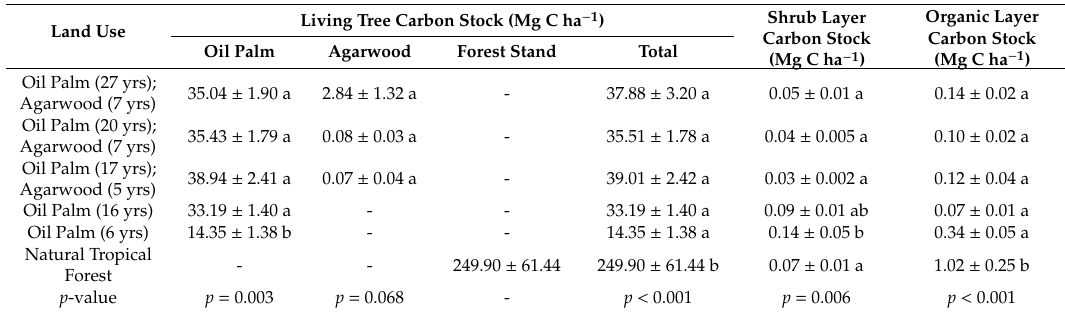
Table 2. Aboveground carbon stock density across different pools (living tree, shrub layer, and organic layer) in different land use.